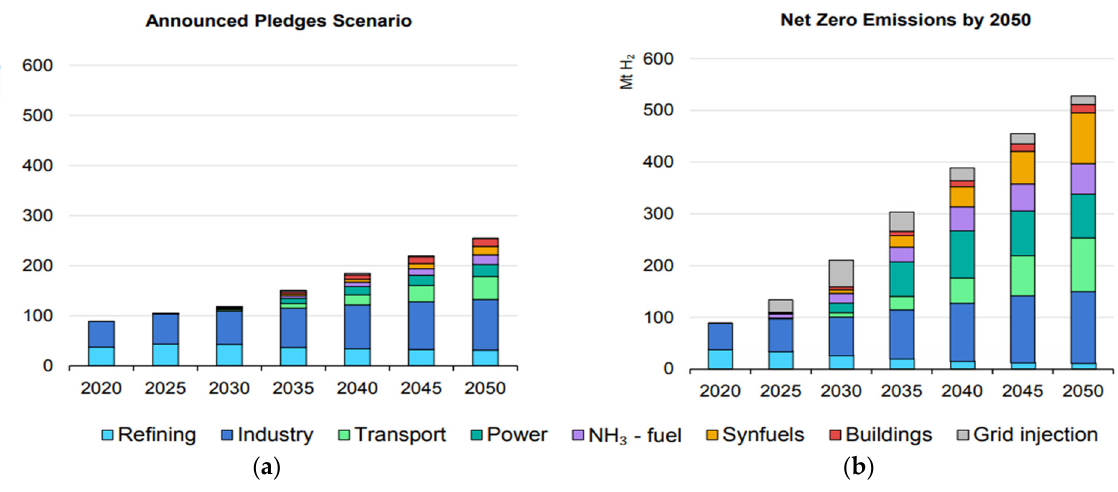
Figure 1. Hydrogen demand by sectors in 2 different scenarios listed as ( a ) announced pledge scenarios stated by governments and ( b ) net-zero emission scenario by 2050 [2].